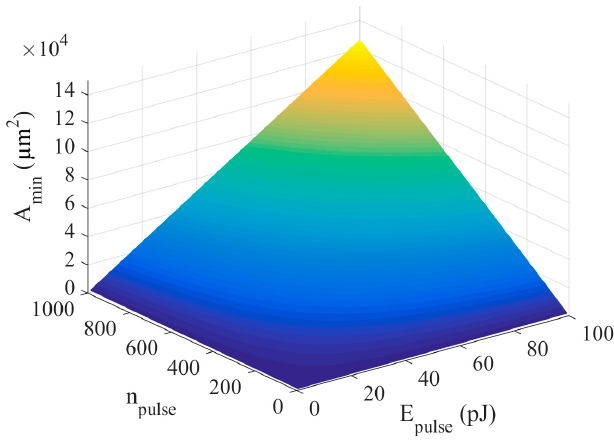
Figure 6. Minimum capacitor area as a function of pulse energy and number of pulses.